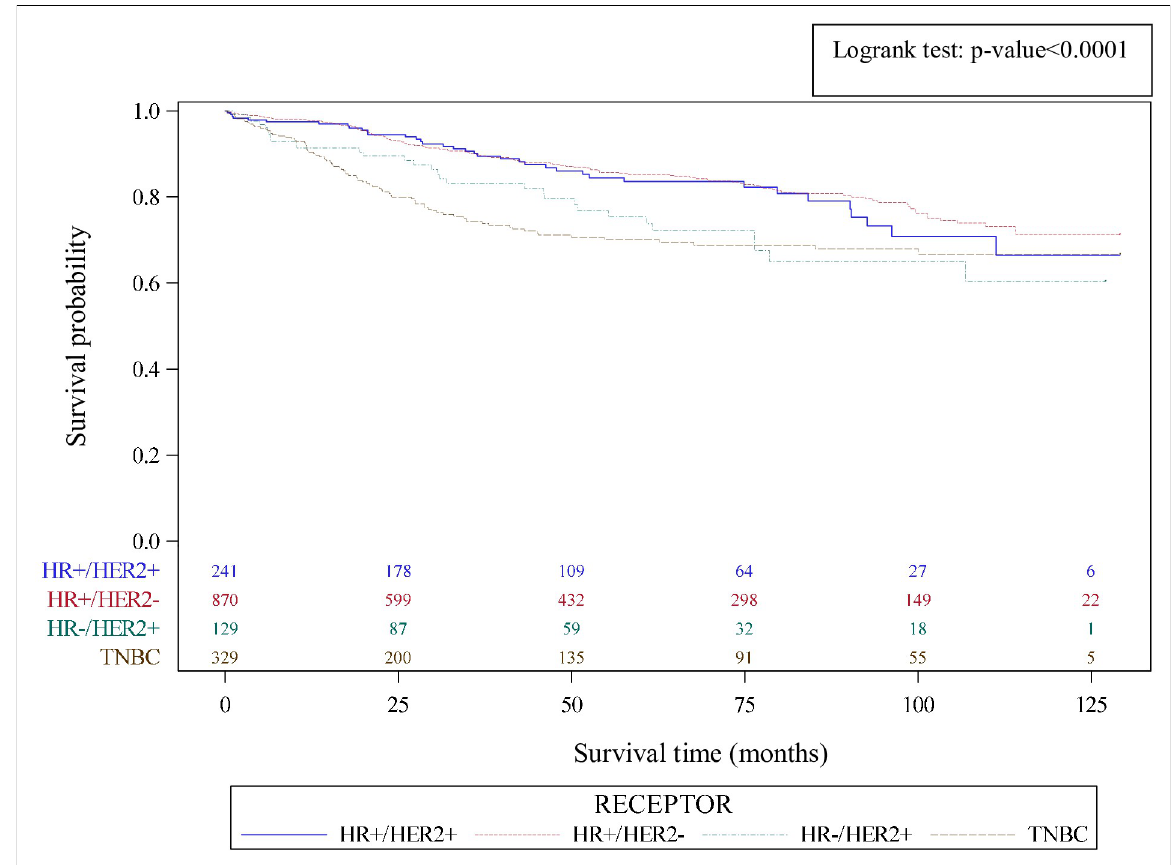
Fig 2. Overall survival in breast cancer patients, stratified by receptor status, Martinique,